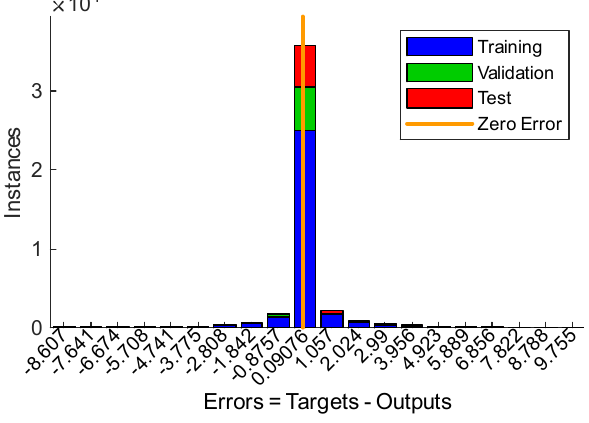
Figure 10. Error (MSE) histogram with 20 bins.